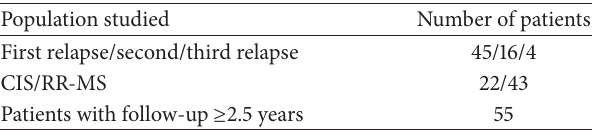
Table 1: Features of the population